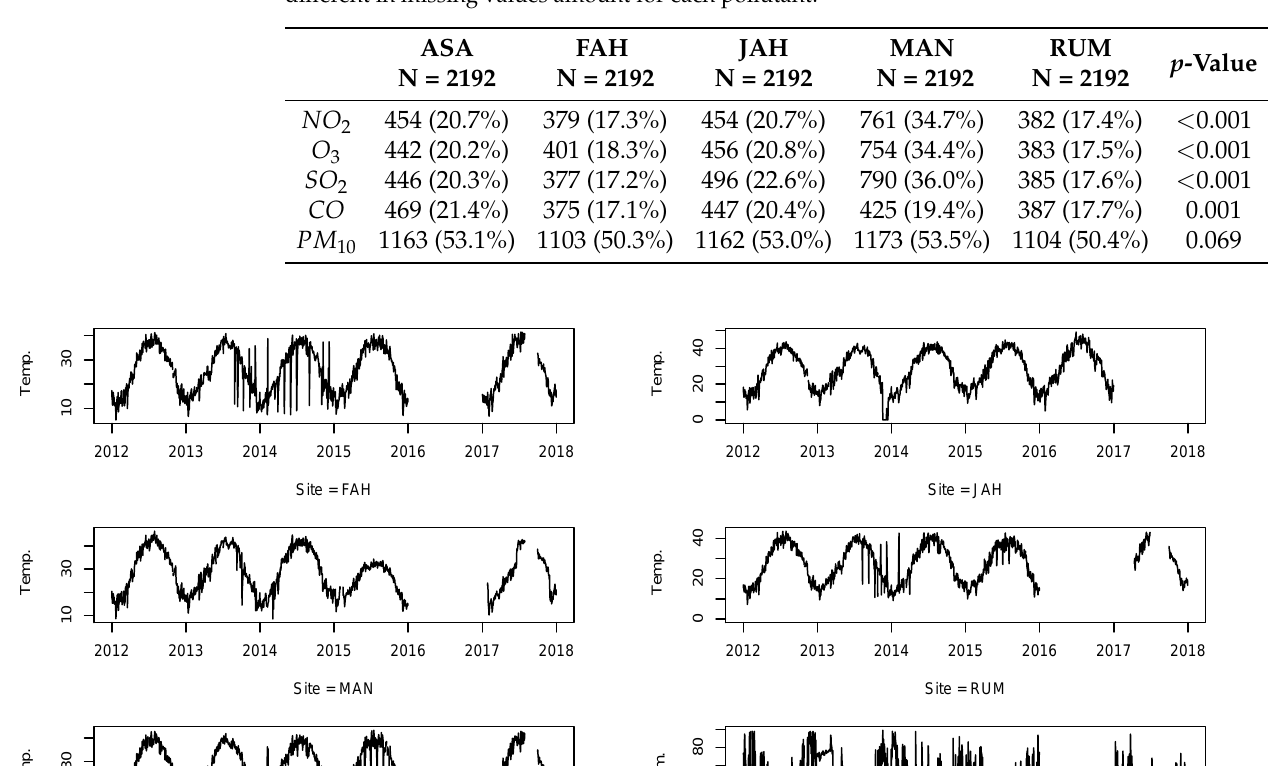
Table 4. Missing data by site. From the results we conclude that all monitoring fixed stations are different in missing values amount for each pollutant.